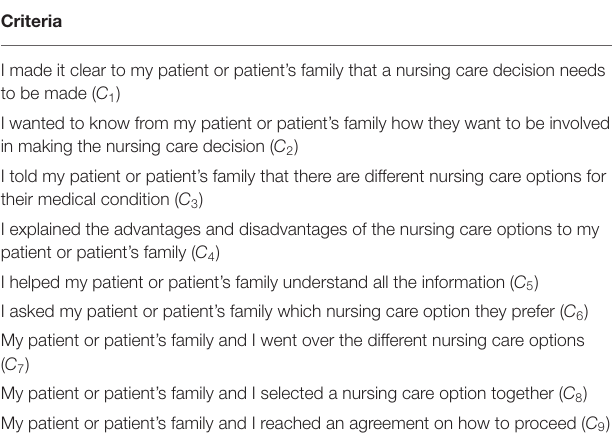
TABLE 1 | The SDM-Q-NUR scale (Cronbach’s Alpha = 0.938).